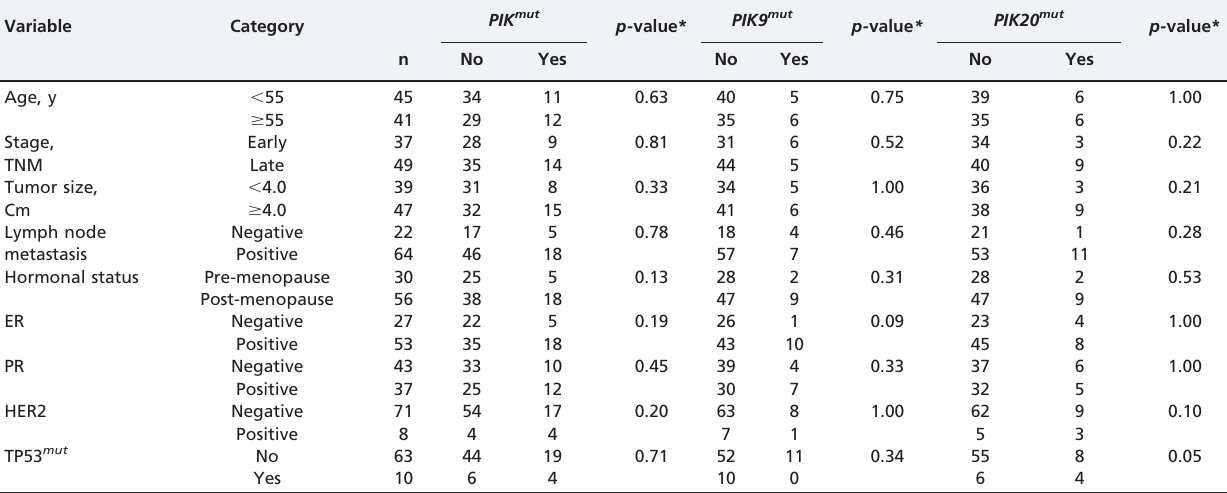
Table 3 - Association between the presence of PIK3CA mutations and patient and tumor characteristics. Variable